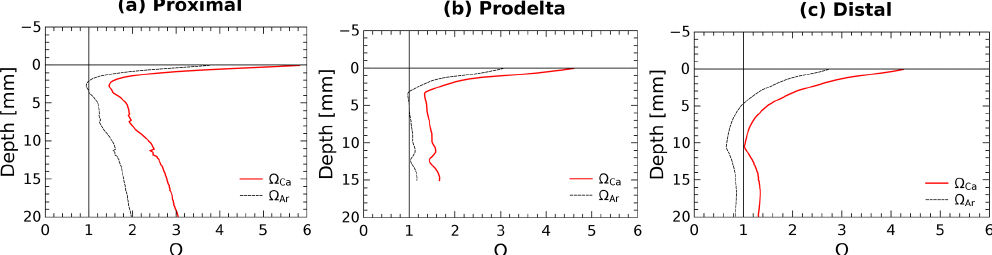
Figure 6. Average pore water saturation states with respect to calcite and aragonite in the first centimeter of the sediment at stations: (a) proximal (St. A, Z), (b) prodelta (St. K), and (c) distal (St. E) calculated using the DIC gradients at the SWI together with the average measured pH